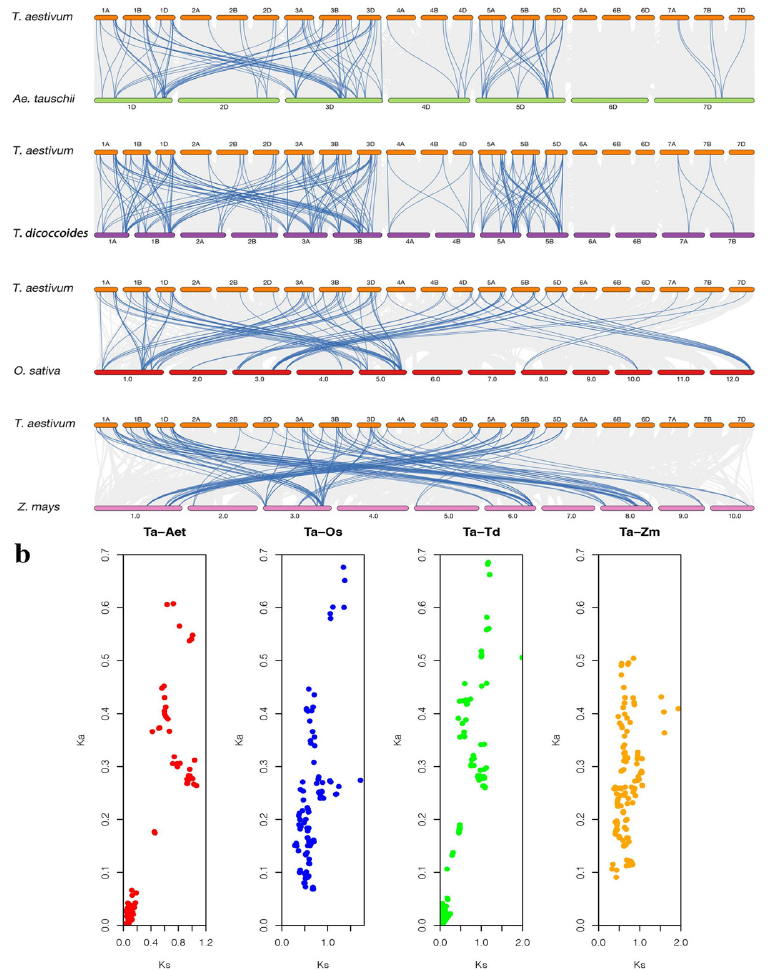
Figure 4. Synteny analysis of TaIQD genes between T. aestivum and four other plant species ( Zea mays , Oryza sativa , Aegilops tauschii , and Triticum dicoccoides ). ( a ) Grey lines in the background and blue lines between different species indicate the collinear blocks and syntenic IQD pairs between wheat and other species, respectively. ( b ) The scatter plot shows the Ka and Ks distributions of homologous pairs between wheat and the different